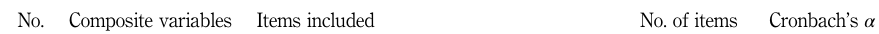
Table III. The reliability test for each composite variable